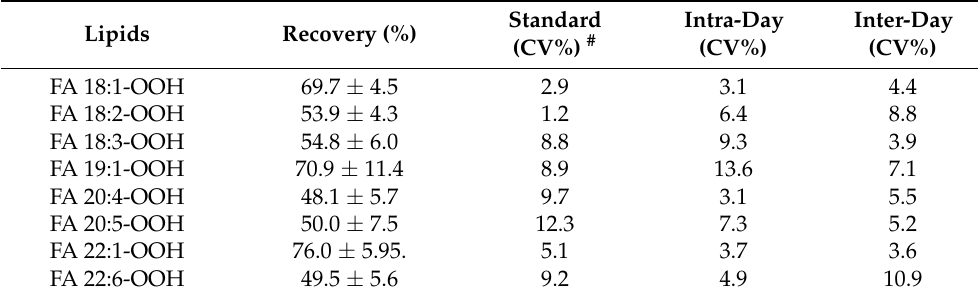
Table 3. Recovery and reproducibility of FAOOH standards in plasma matrix (CV: coefficient of variance) # The value corresponds to the variance among FAOOH standards derivatized and injected directly without